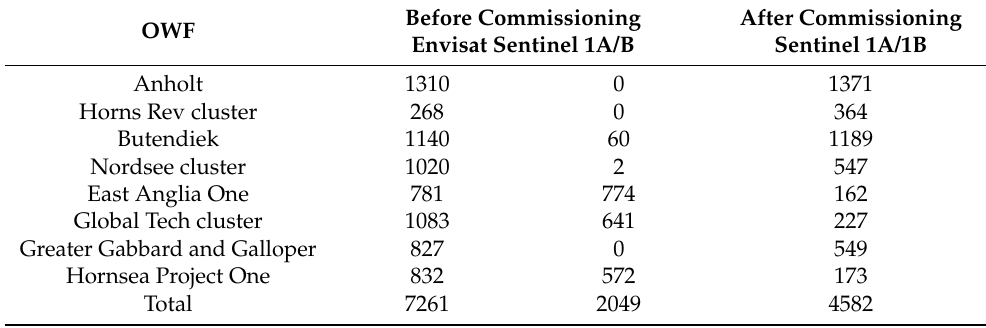
Table 2. Number of available SAR scenes before and after commissioning of each OWF and cluster. Before Commissioning After OWF Envisat Sentinel 1A/B